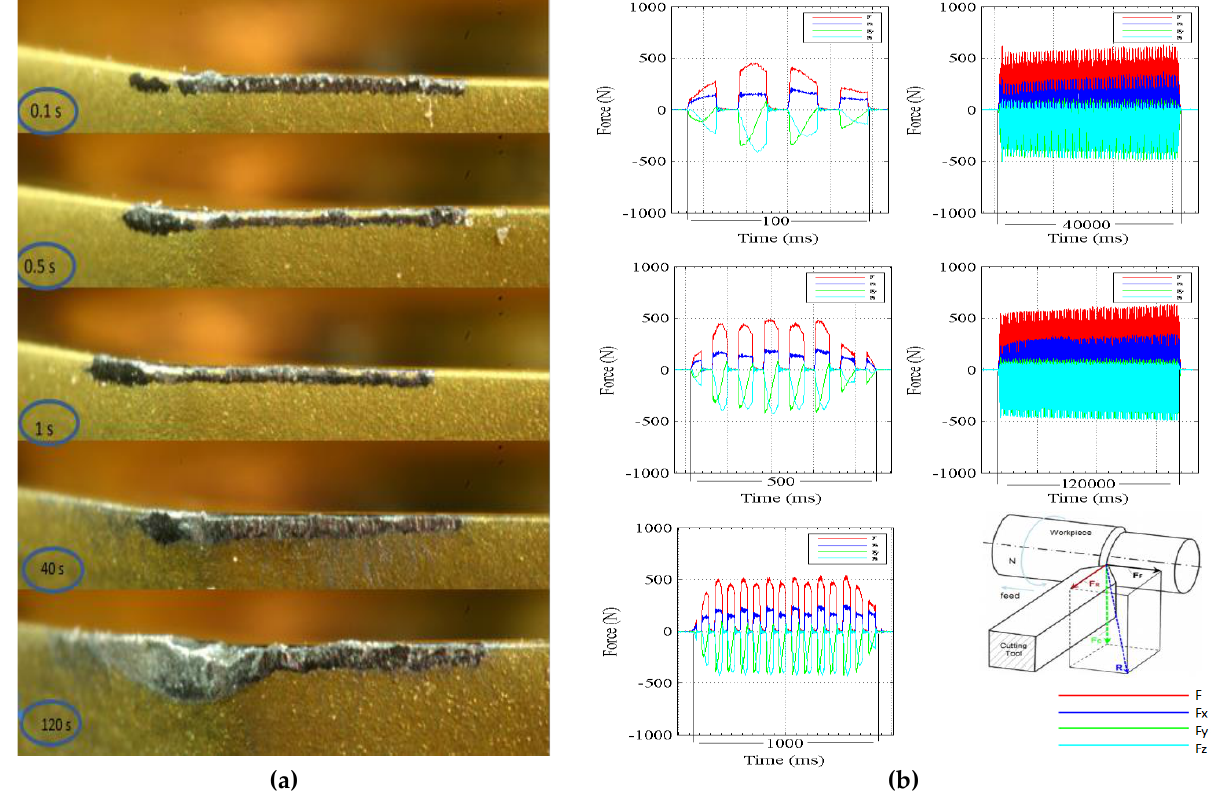
Figure 5. ( a ) Tool wear after different moments of machining and ( b ) corresponding captured cutting forces.